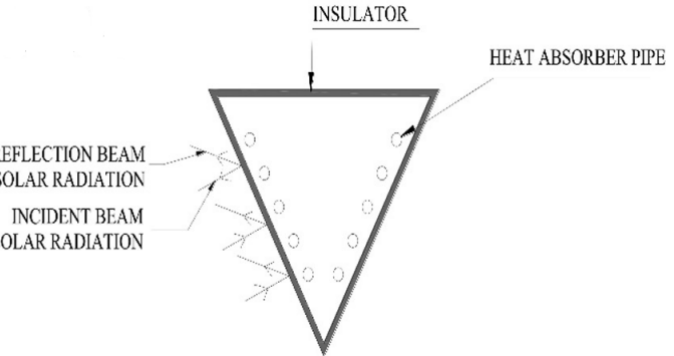
Figure 15. The cross-sectional view of heat receiver tested in [42]. Reprinted with permission from Ref. [42]. 2018, Elsevier.